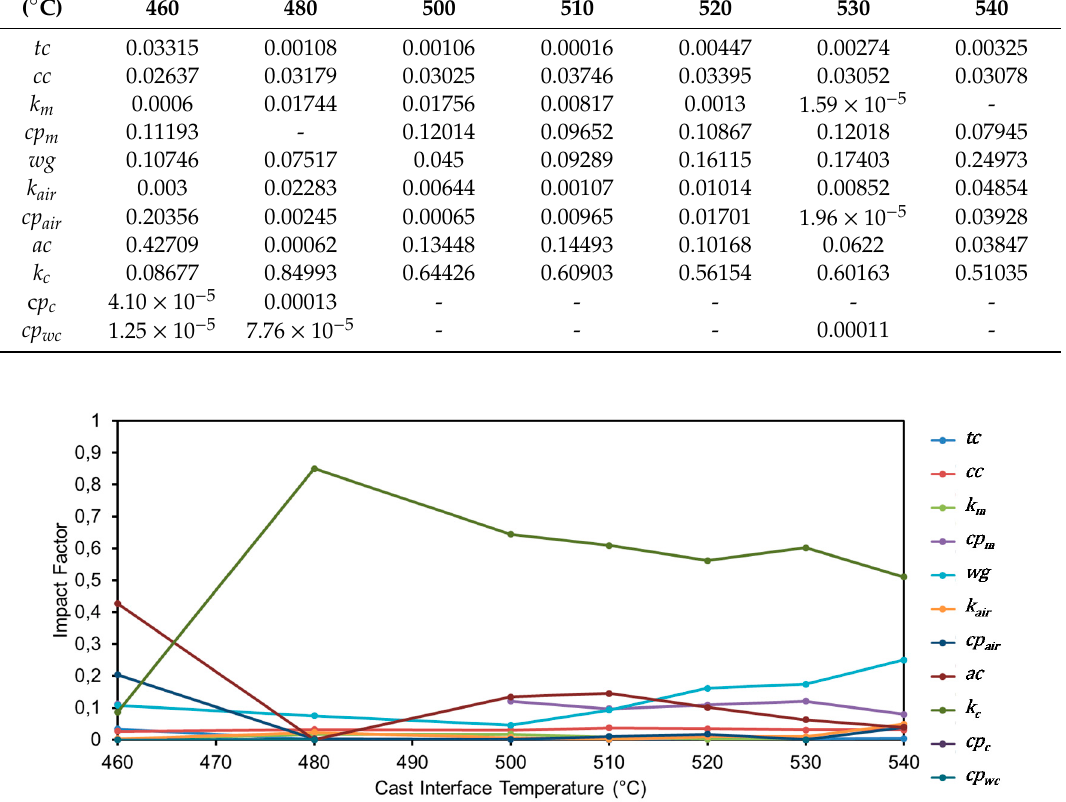
Figure 5. Development of the impact factors for the HTC between casting and core over the interface temperatures.